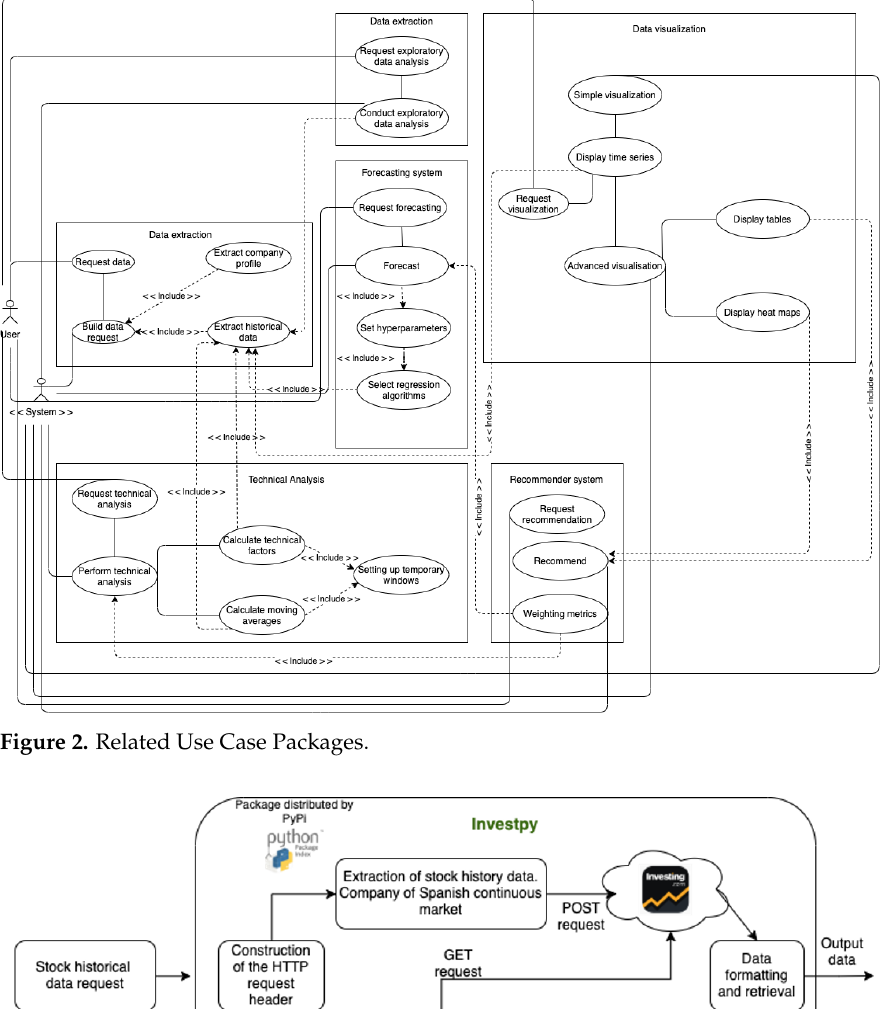
Figure 2. Related Use Case Packages.